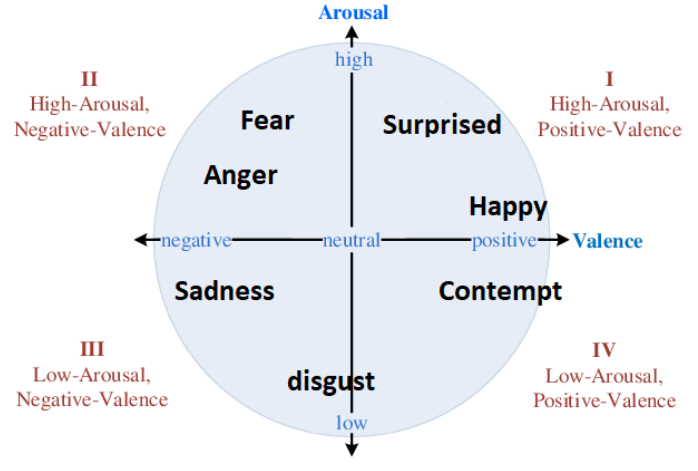
Figure 2. Two-dimensional valence-arousal space for emotions trained in